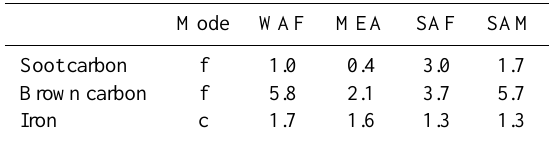
Table 3. Maximum monthly climatological averages for absorbing components of the fine (f) or coarse (c) mode, in percent by volume. The AERONET sites are listed in Table 2 and the regions corre- spond to West Africa (WAF), Middle East (MEA), southern Africa (SAF), and South America